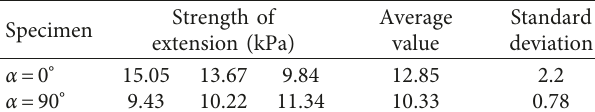
Table 1: Result of the tensile